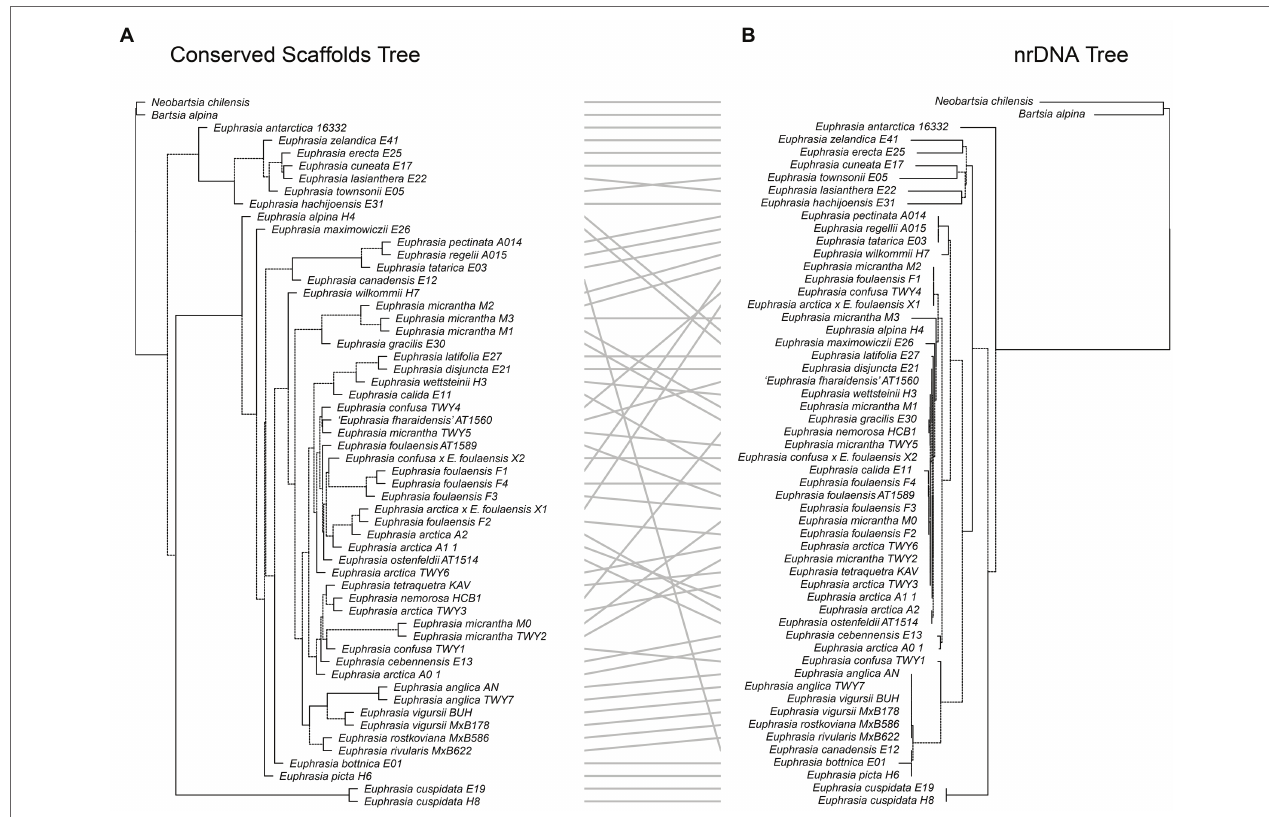
FIGURE 6 | Tanglegram comparing (A) the species tree from the conserved nuclear scaffolds and (B) the maximum likelihood phylogeny for the